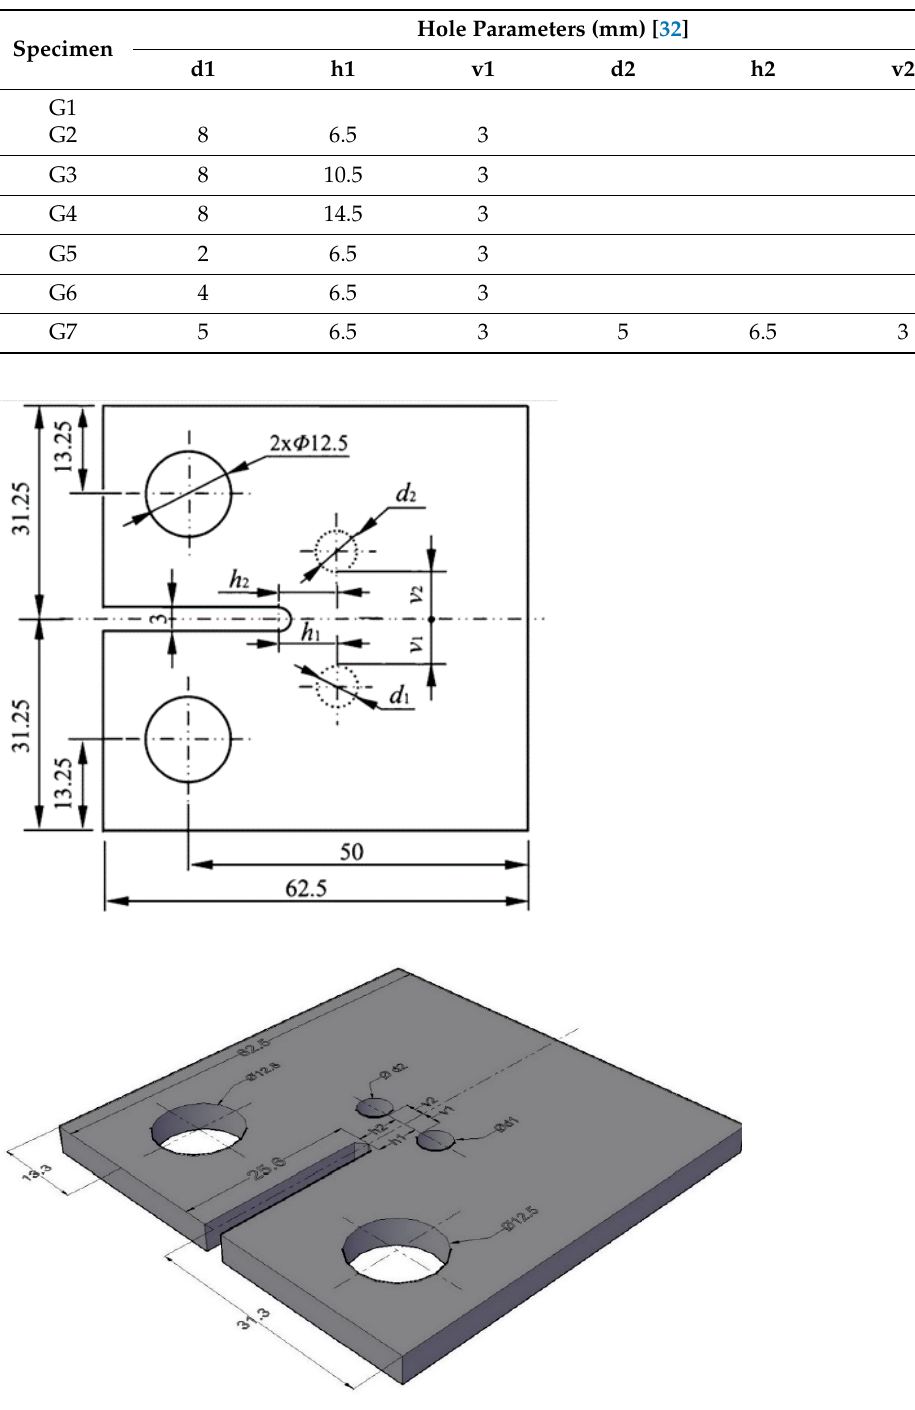
Figure 3. 2D and 3D Schematic representation of specimen .